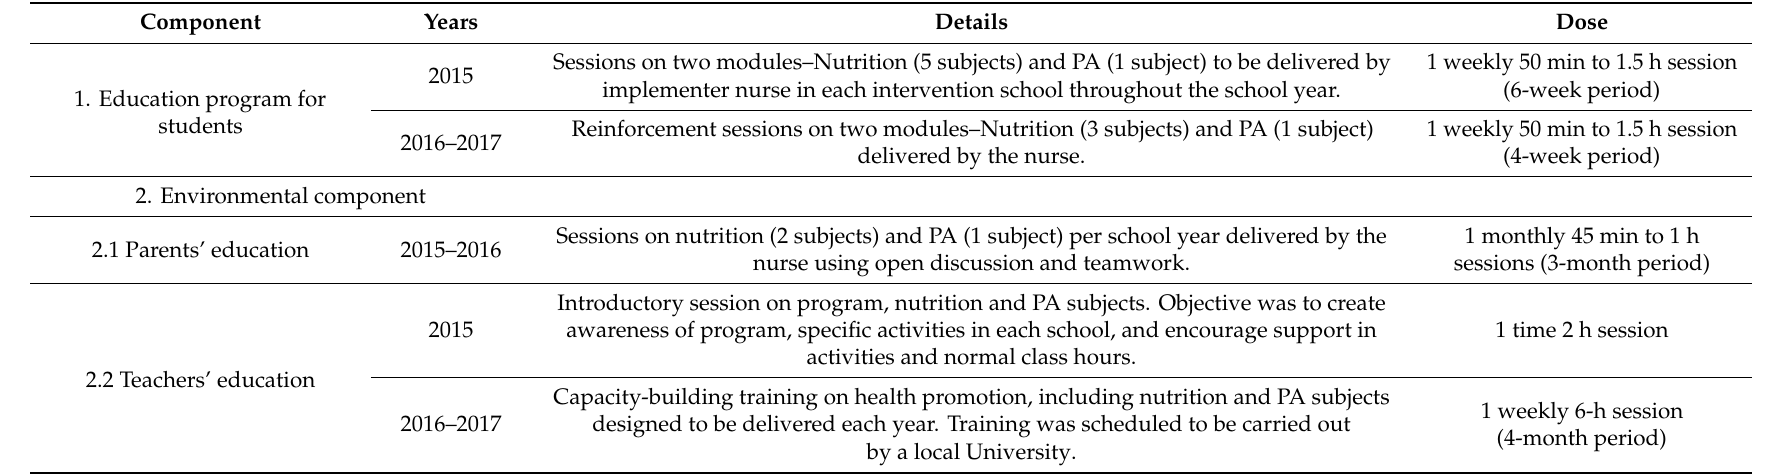
Table 2. Components and Planned Delivery of the HPS Obesity Prevention Program in Lima and Callao,